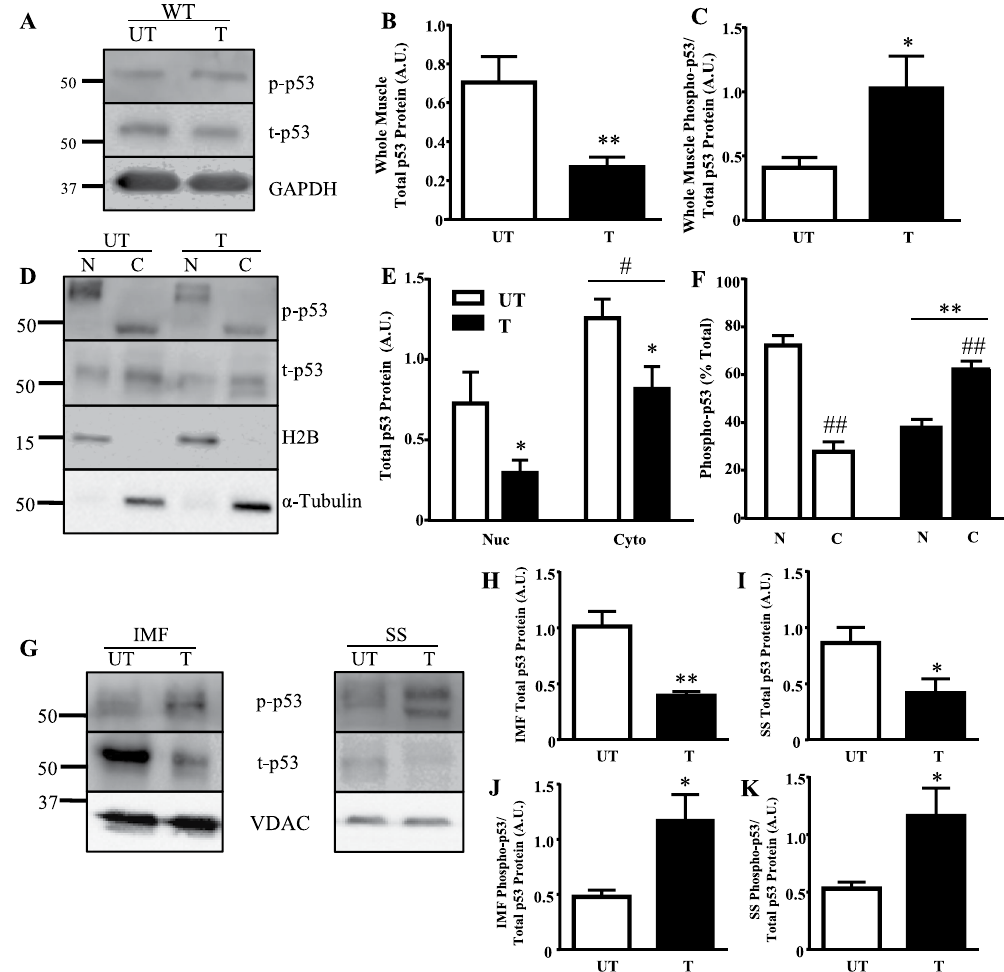
Figure 1. p53 subcellular localization with training. ( A ) Whole muscle ( B ) total p53 protein and ( C ) phosphorylated p53-Ser 15 protein was measured in WT mice. GAPDH was utilized as the loading control for all immunoblotting in whole muscle (n = 6–7/group); * p ≤ 0.05, ** p ≤ 0.01, UT vs. T, Student’s t-test. ( D ) p53 protein was measured in nuclear and cytosolic fractions in WT mice. H2B was used as a nuclear loading control and α -tubulin was used as a cytosolic loading control. Basally and with training, nuclear and cytosolic ( E ) total p53 protein, and ( F ) percent total of phosphorylated p53-Ser 15 protein was measured (n = 4–5/group); * p ≤ 0.05, ** p ≤ 0.01, UT vs. T; # p ≤ 0.05, ## p < 0.01, Nuclear vs. Cytosolic (n = 4–5/group), Student’s t-test and 2-way ANOVA. A main effect of training was observed. ( G ) Mitochondrial p53 protein was examined in SS and IMF mitochondrial subfractions. VDAC was utilized as a mitochondrial loading control. Total p53 protein in ( H ) IMF, and ( I ) SS mitochondria was measured (n = 4–5/group); * p ≤ 0.05, ** p ≤ 0.01, UT vs. T, Student’s t-test. Activated p53, corrected for total, was additionally measured in ( J ) IMF, and ( K ) SS mitochondria (n = 4–5/group); * p ≤ 0.05, UT vs. T, Student’s t-test. Data are presented as mean ±